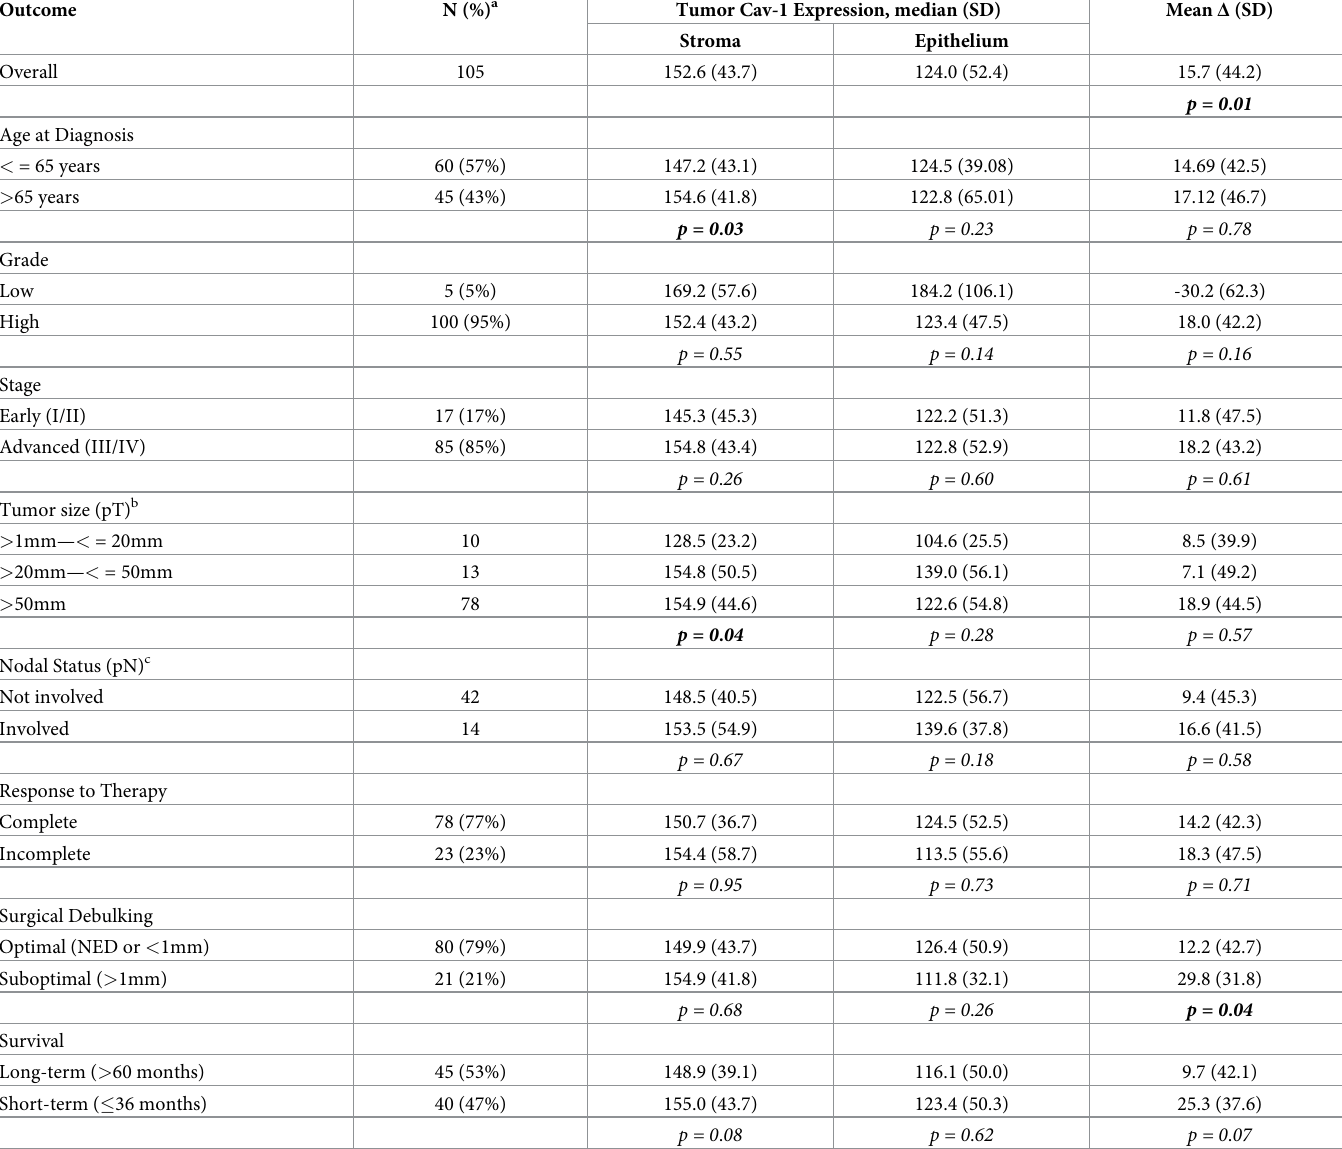
Table 2. Immunofluorescent Cav-1 expression in serous ovarian cancer by clinical characteristics in Cohort 2. Outcome N (%)